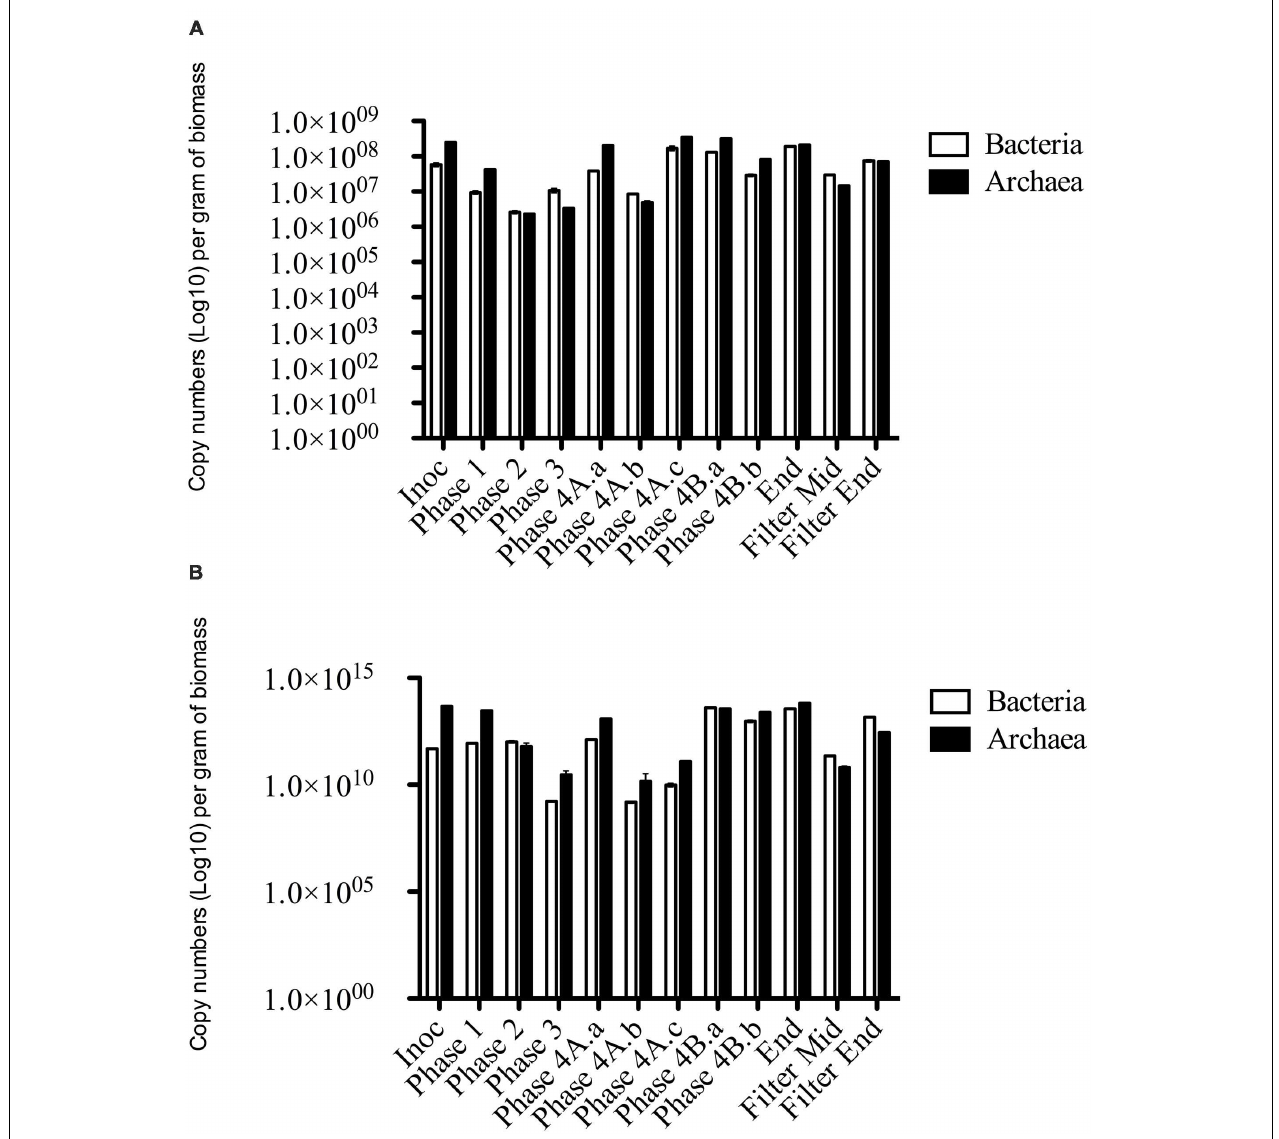
FIGURE 4 | qPCR data of Bacterial and Archaeal copy numbers (log scale) for (A) DNA and (B) cDNA from biomass samples throughout the